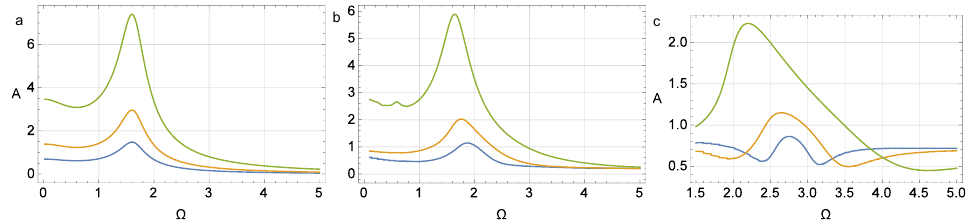
Figure 17. Amplitude–frequency characteristics for (42), ω = 1.2, σ = 1.5, and K = 1 (blue line), K = 2 (orange line), K = 5 (green line). Parameters of the Bouc–Wen model: A = 1, β = 0.1, γ = 0.9, and n = 3, initial conditions ϕ ( 0 ) = 1, v ( 0 ) = 1, and ( a ) H = 0, ( b ) H = 1, or ( c ) H = 5